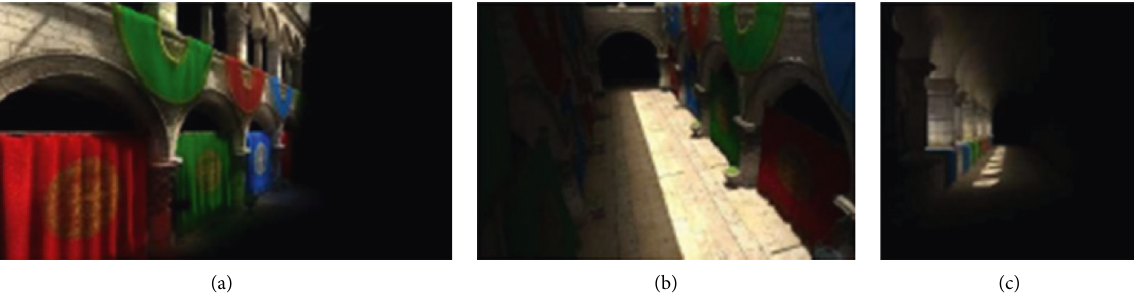
Figure 7: Noise reduction effect of Monte Carlo algorithm based on deep neural network. (a) Perspectives 1. (b) Perspectives 2. (c) Perspectives 3.